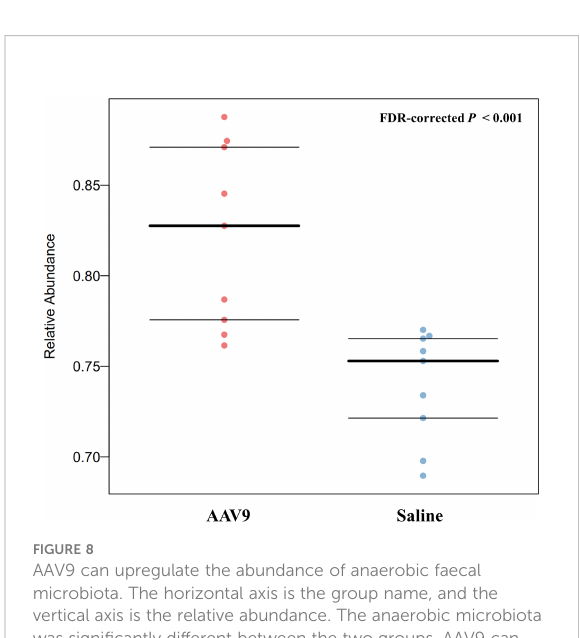
FIGURE 8 AAV9 can upregulate the abundance of anaerobic faecal microbiota. The horizontal axis is the group name, and the vertical axis is the relative abundance. The anaerobic microbiota was signi fi cantly different between the two groups. AAV9 can signi fi cantly upregulate the relative abundance of anaerobic microbiota (FDR-corrected P < 0.001, Mann ‐ Whitney-Wilcoxon).